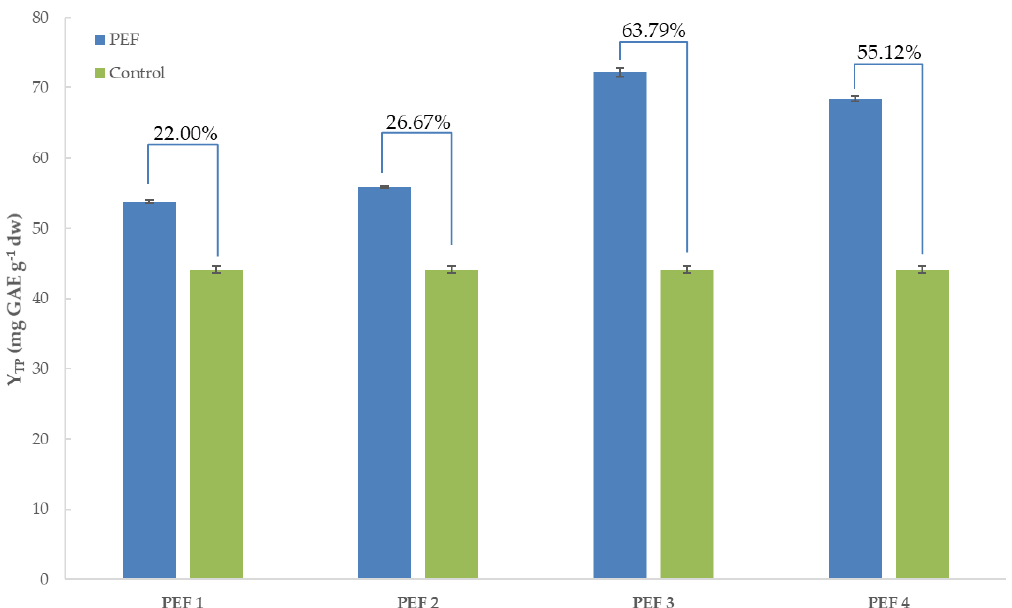
Figure 1. Total phenolics, Y TP , for Rosa canina fruits PEF samples acquired in different electric field intensities, compared to control sample.